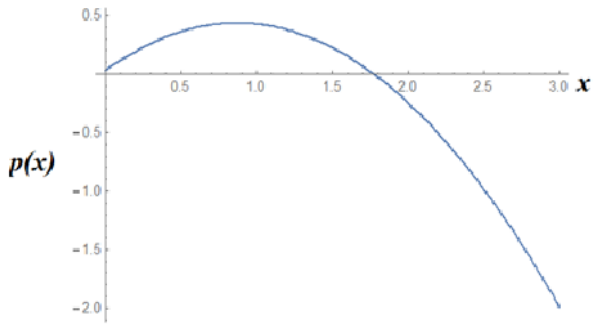
Again the various computations performed with the help of Mathematica computing algebra pack, the stress has been computed for δ = 3 and 𝛾 = 0.7.